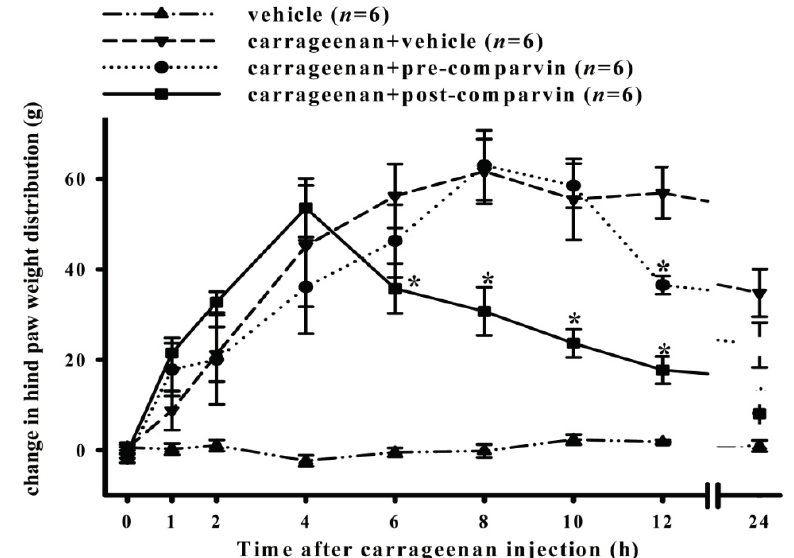
Figure 5. Time course of the effects of comaparvin on weight-bearing by rat hind paws after carrageenan injection. The baseline was set as the weight-bearing differential before carrageenan injection. Post-treatment of comaparvin (30 mg/kg) significantly inhibited weight-bearing defects at 6, 8, 10, 12, and 24 h after stimulation with carrageenan. Pre-comaparvin, pre-treatment of comaparvin at 1 h before carrageenan injection. Post-comaparvin, comaparvin post-treatment at 4 h after carrageenan injection. Data are the mean ± SEM values. * p < 0.05 compared with the carrageenan + vehicle